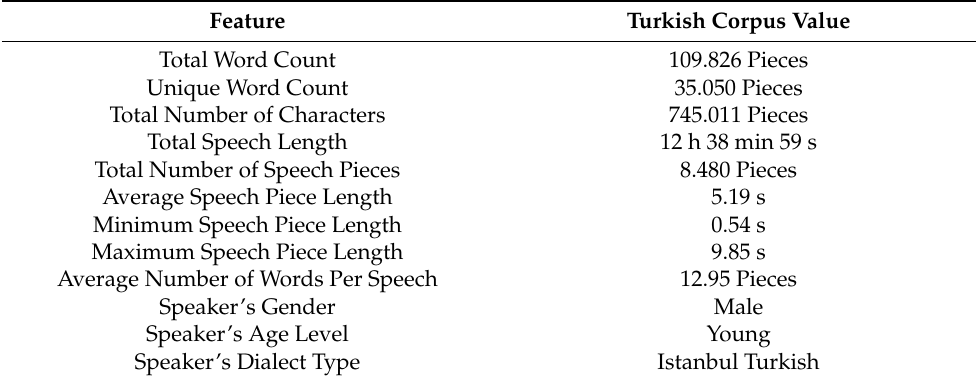
Table 2. Table of feature units for the Turkish